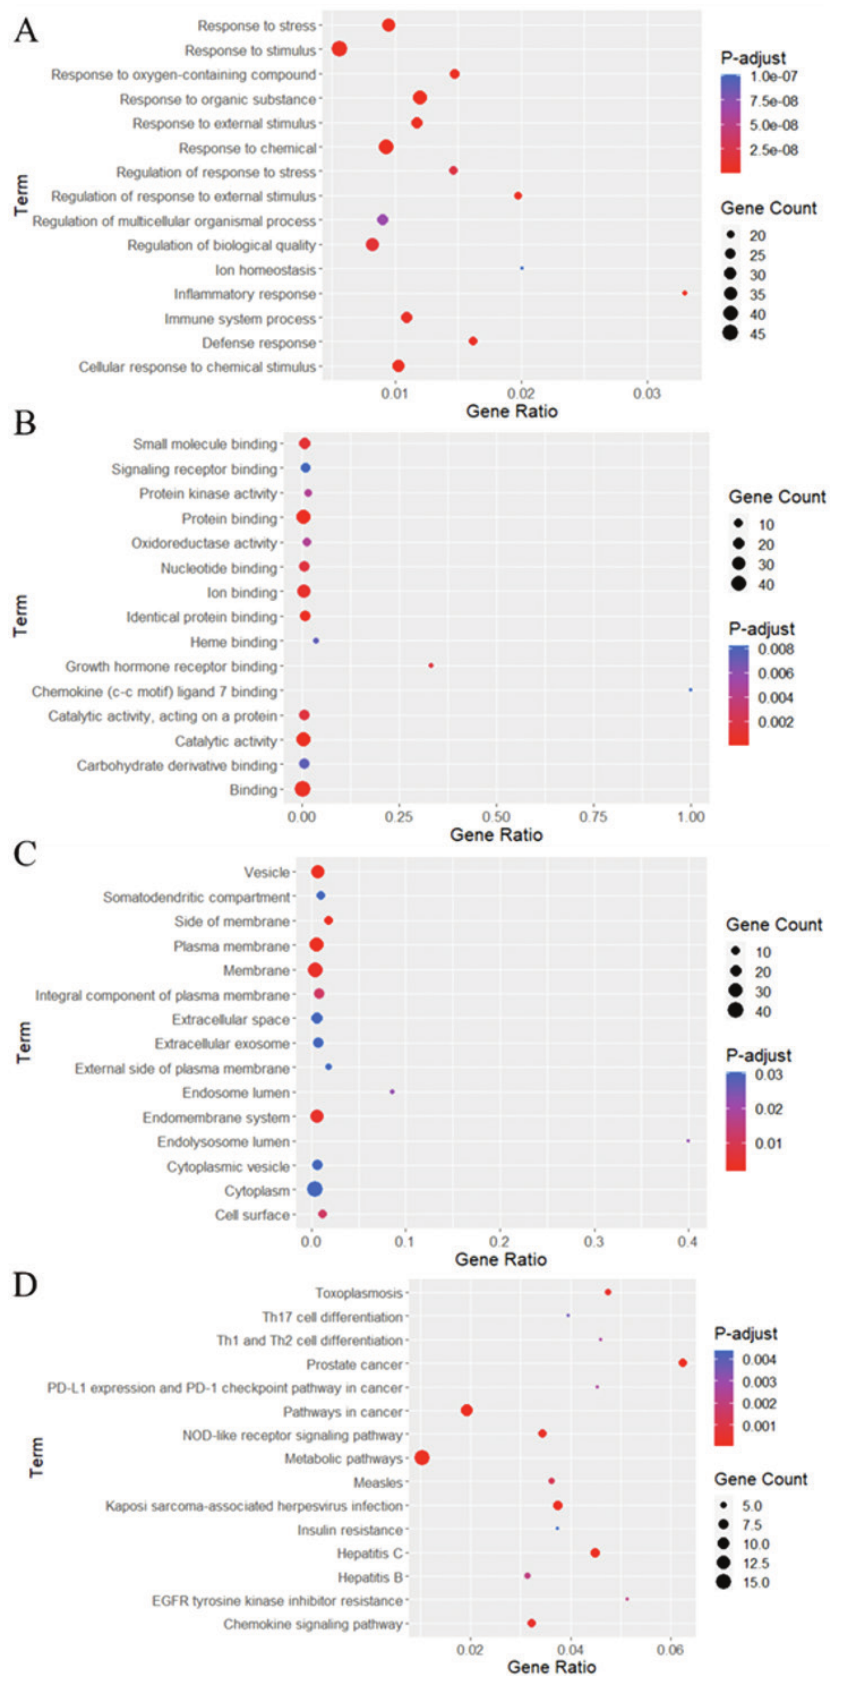
Figure 5. GO and KEGG pathway enrichment analysis. A. Biological process; B. Molecular function; C. Cellular component; D. KEGG